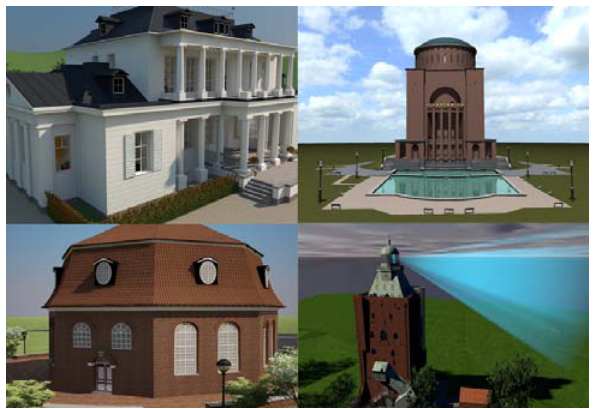
Figure 1. Examples for manual texture mapping for photo- realistic visualisation – Gossler House (Cinema 4D) and Planetarium Hamburg (Maya), Church in Hamburg-Niendorf (3ds Max) and the light house of Neuwerk (Cinema 4D) The Geomagic software offers another possibility for texture mapping. Identical points are interactively measured in the meshed 3D surface model and in the related image, which is used as texture. These points are used to determine the transformation parameters for the texture between model and image. Fig. 2 represents the textured 3D building model of the fortress Kristiansten in Trondheim, which has been scanned with a terrestrial laser scanner Riegl VZ-400. The registered scans were meshed afterwards to a 3D model (consisting of 2,954,935 triangles) and textured manually using the before mentioned procedure.